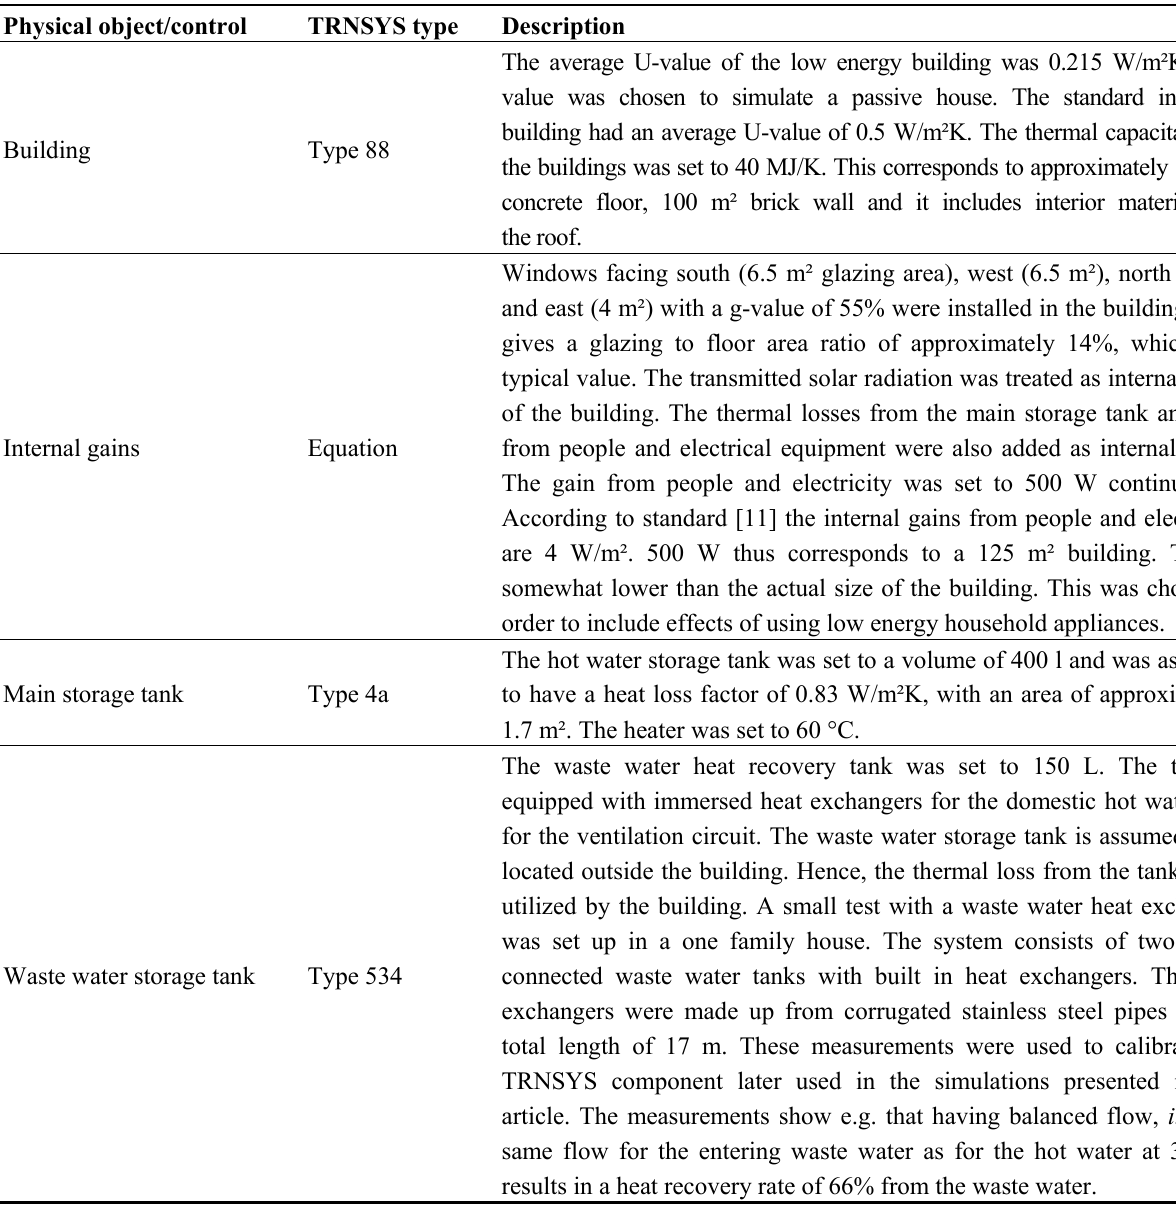
Table 1. Input data for the